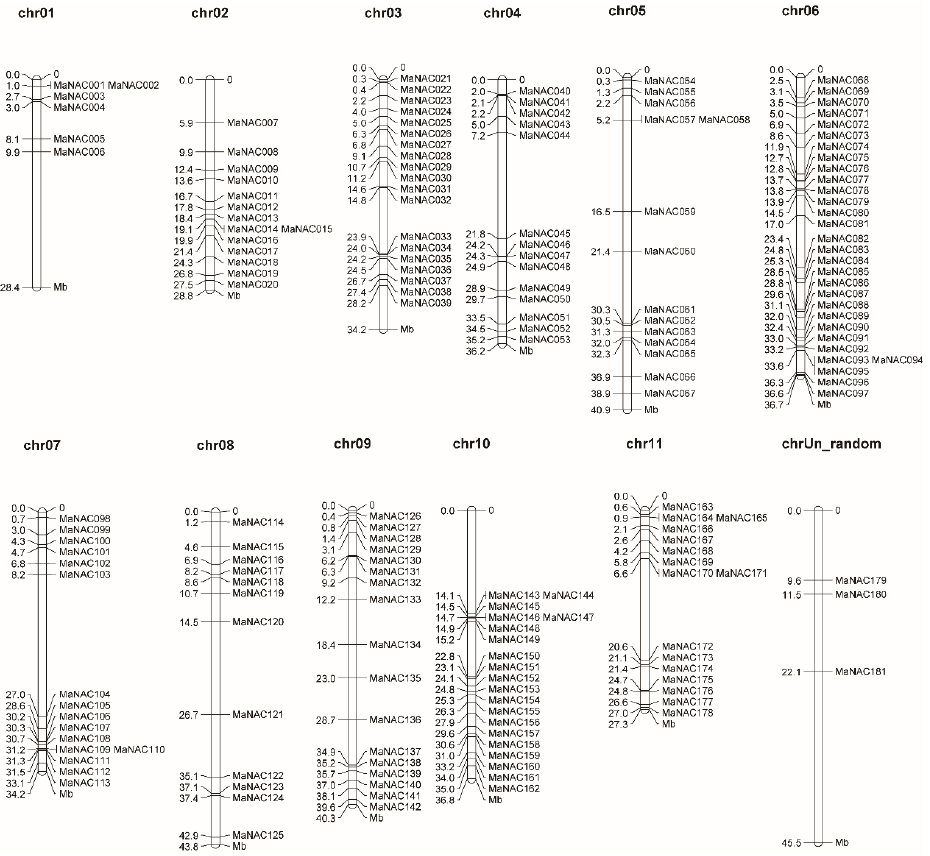
Figure 1. Chromosomal locations of NAC genes in M. acuminata . The chromosomal position of each MaNAC was mapped according to the genome of M. acuminata . The chromosome number is marked at the top of each chromosome and the unit for the scale is megabases